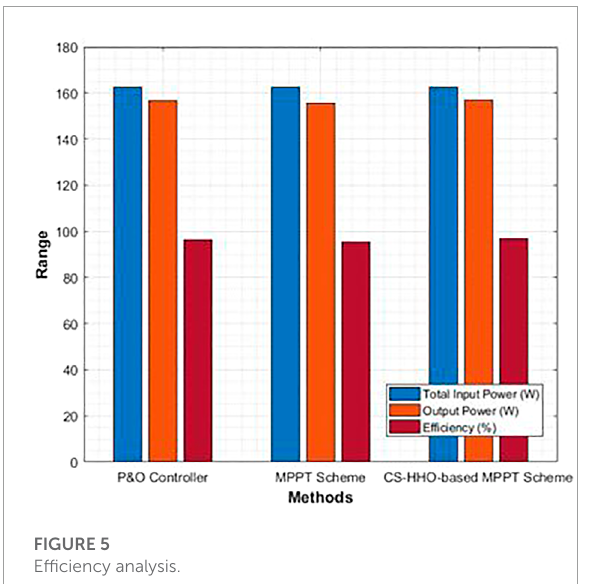
FIGURE 5 Efficiency analysis.